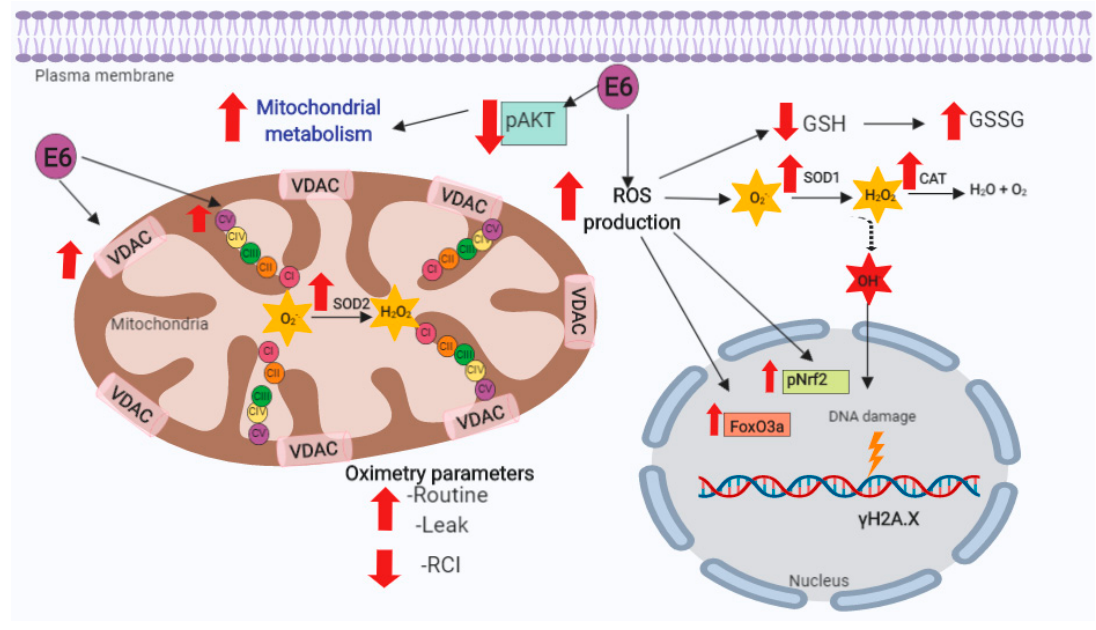
Figure 12. Integrative scheme. E6 oncoproteins from human papillomavirus type 16 (HPV16) and 18 (HPV18) decrease the levels of serine 473 phosphorylated-protein kinase B (pAkt), favoring the mitochondrial oxygen consumption and mitochondrial mass increase. E6 increases basal respiration (Routine), respiration leak and mitochondrial decoupling, while respiratory control index (RCI) significantly decreases, which could be associated to the increase in reactive oxygen species (ROS), oxidative stress (OS), and deoxyribonucleic acid (DNA) damage. Superoxide dismutase (SOD), catalase (CAT), glutathione (GSH), glutathione disulfide (GSSG), voltage-dependent anion channels (VDAC), superoxide anion (O 2. − ), hydrogen peroxide (H 2 O 2 ), hydroxyl radical (OH . − ), nuclear factor (erythroid-derived 2)-like 2 (Nrf2) phosphorylated in serine 40 (pNrf2), forkhead box O3 (FoxO3a), gamma H2A histone family member X ( γ H2AX), and mitochondrial complexes I to V (CI, CII, CIII, CIV, CV).The yellow ray indicates damage to DNA.